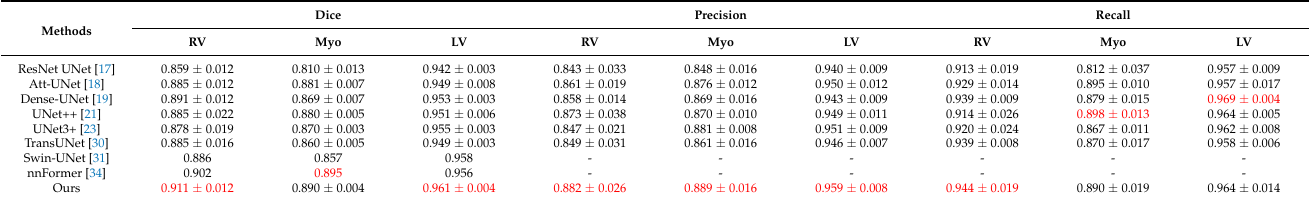
Table 2. Comparison with state-of-the-art methods on the ACDC. All methods were run 10 times to take the average and standard deviation (average ± standard deviation). The best performance is shown in red (the data of Swin-UNet and nnFormer are from the corresponding original literature, and the data of other methods are that we train under the same conditions).